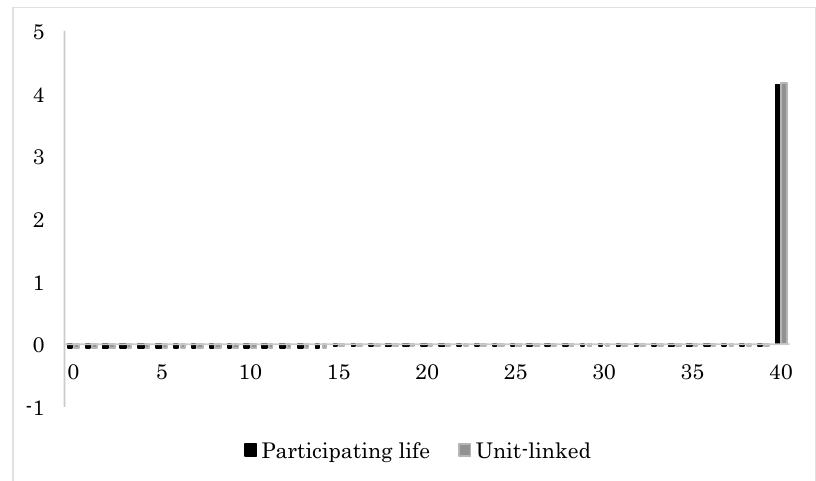
Figure 11. Approximated expected cash flows for the participating life insurance policy and the unit-linked insurance policy as a function of time.